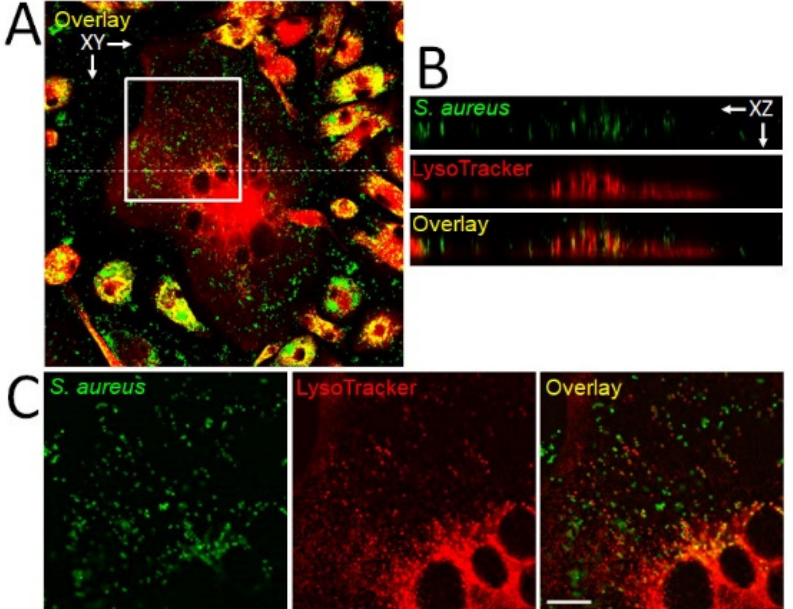
Figure 3. Internalization of S. aureus by mature OC and pre-OCs. Murine bone-marrow monocytes were differentiated in RANKL and M-CSF for 3 days, then infected with GFP-labeled S. aureus as previously described [97]. After 18 h, cultures were fixed and stained with LysoTracker and imaged using a Nikon A1RSi confocal microscope and Nikon NIS-C Elements software. ( A ) Low-power image of a multinucleated OC surrounded by mononuclear pre-OCs in the XY plane. In this image, the degree of co-localization of bacteria (green) and lysosomes (red), indicated in yellow, is particularly variable in the pre-OCs, but similar variation occurs in OCs as well, as previously shown [97]. ( B ) Images in the XZ plane along the dotted line in (A) show that the bacteria are inside, rather than on top of, the OC. ( C ) XY plane images from the white box in A demonstrate only partial co-localization of bacteria and lysosomes in the mature OC. Scale bar, 10 µm. Microbes that avoid lysosomes are more likely to survive and proliferate than those that end up in these acidified vesicles.